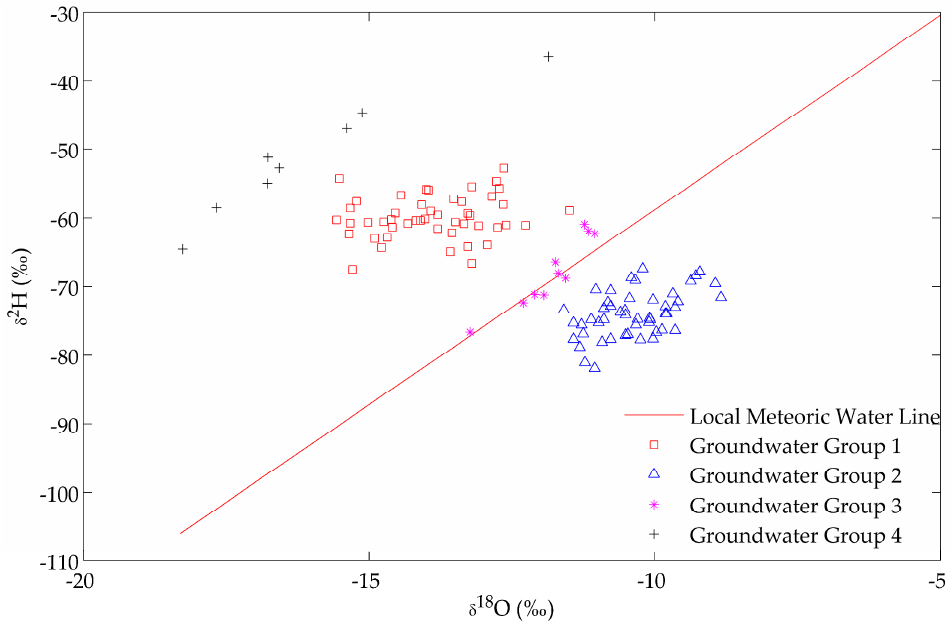
18 O groundwater sampling groups and the Figure 3. Plot of δD vs. δ (cid:2869)(cid:2876) O groundwater sampling groups and the LWML. Figure 3. Plot of δ D vs. δ